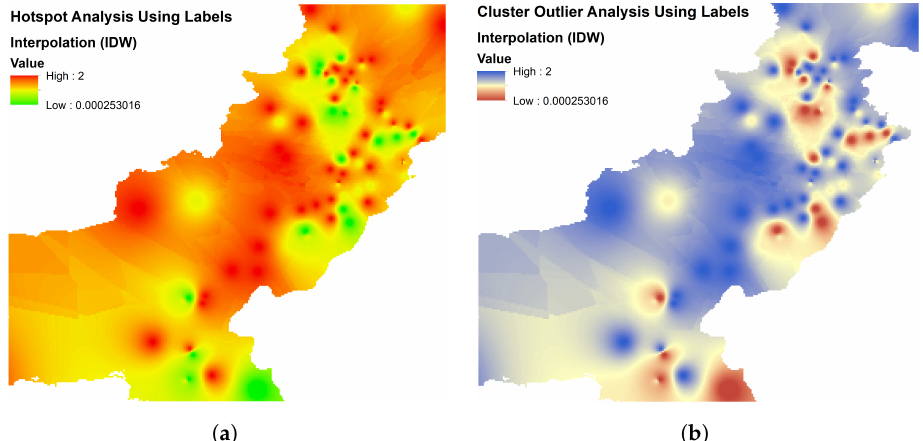
Figure 12. Inverse distance weighted interpolation results: ( a ) hotspot points data; ( b ) cluster outlier points data.